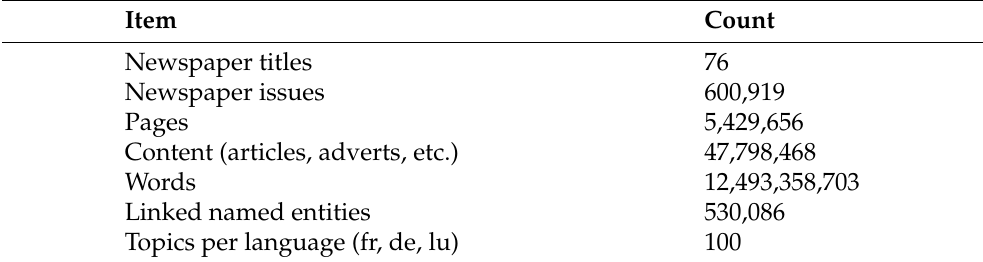
Table 1. Overview of the size of the impresso corpus and its enrichment. These numbers reflect the status quo at the time of writing and prior to a planned corpus